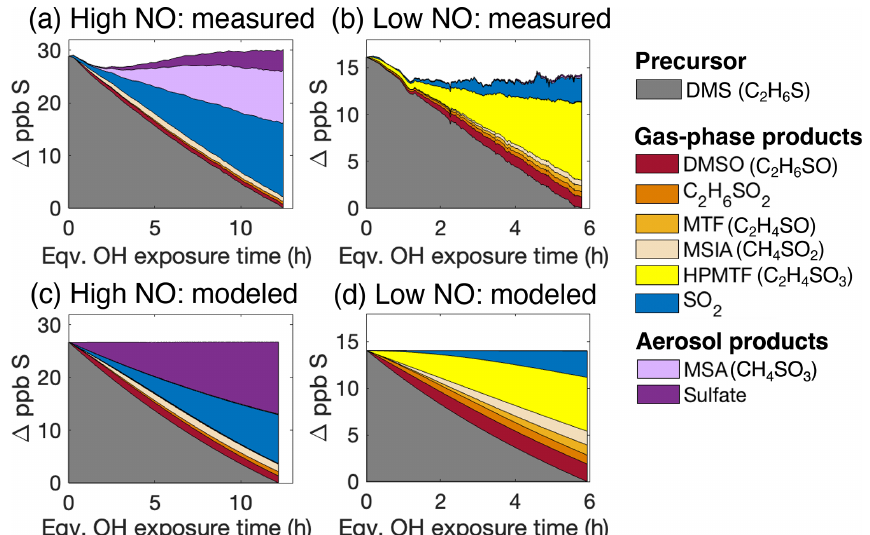
Figure 2. Stacked plots showing the total sulfur measured ( a and b ) and modeled ( c and d ) under high-NO ( a and c ) and low-NO ( b and d ) conditions. Panels (a) and (c) are for Exp. 1, and panels (b) and (d) are for Exp. 2a. Data shown in panel (b) are from DMS- 12 C 2 and DMS- 13 C 2 combined. Products with a formula of C 2 H 6 SO 2 may be DMSO 2 and/or CH 3 SCH 2 OOH; under high-NO conditions, they are likely to be predominantly DMSO 2 . Minor products detected but not listed in the legend due to their very low concentrations include CH 2 SO 2 (a sulfene or thioacid) and CH 3 SO 6 N (likely methanesulfonyl peroxynitrate). Note that y axes denote the changes in concentrations of the precursor and